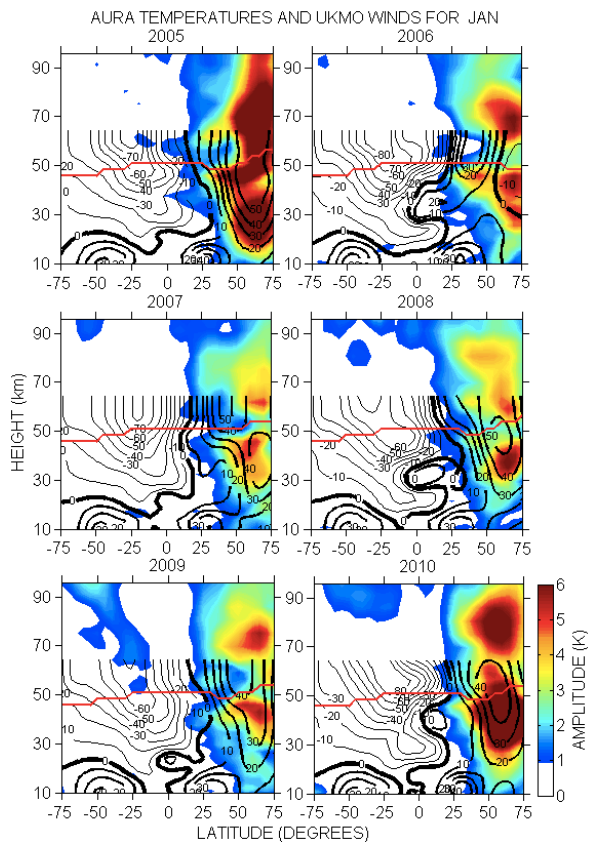
Fig. 13. Monthly-mean Aura temperature amplitudes for post Northern Hemisphere major SSW’s, January 2005–2010. Also plot- ted are the UKMO composite monthly-mean zonal winds (ms − 1 ) as contour lines and the stratopause height as a red contour